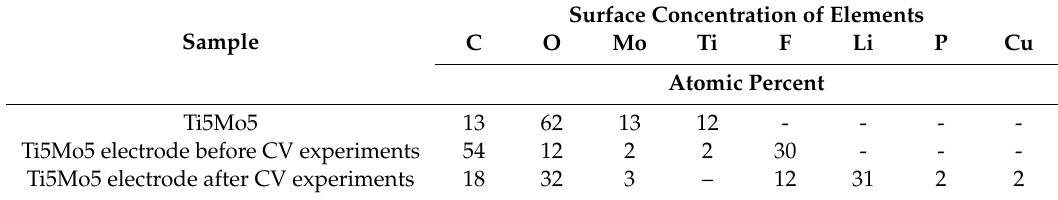
Table 4. Elemental surface composition of sample Ti5Mo5 as well as Ti5Mo5 electrodes before and after cyclic voltammetry experiments, calculated based on XPS